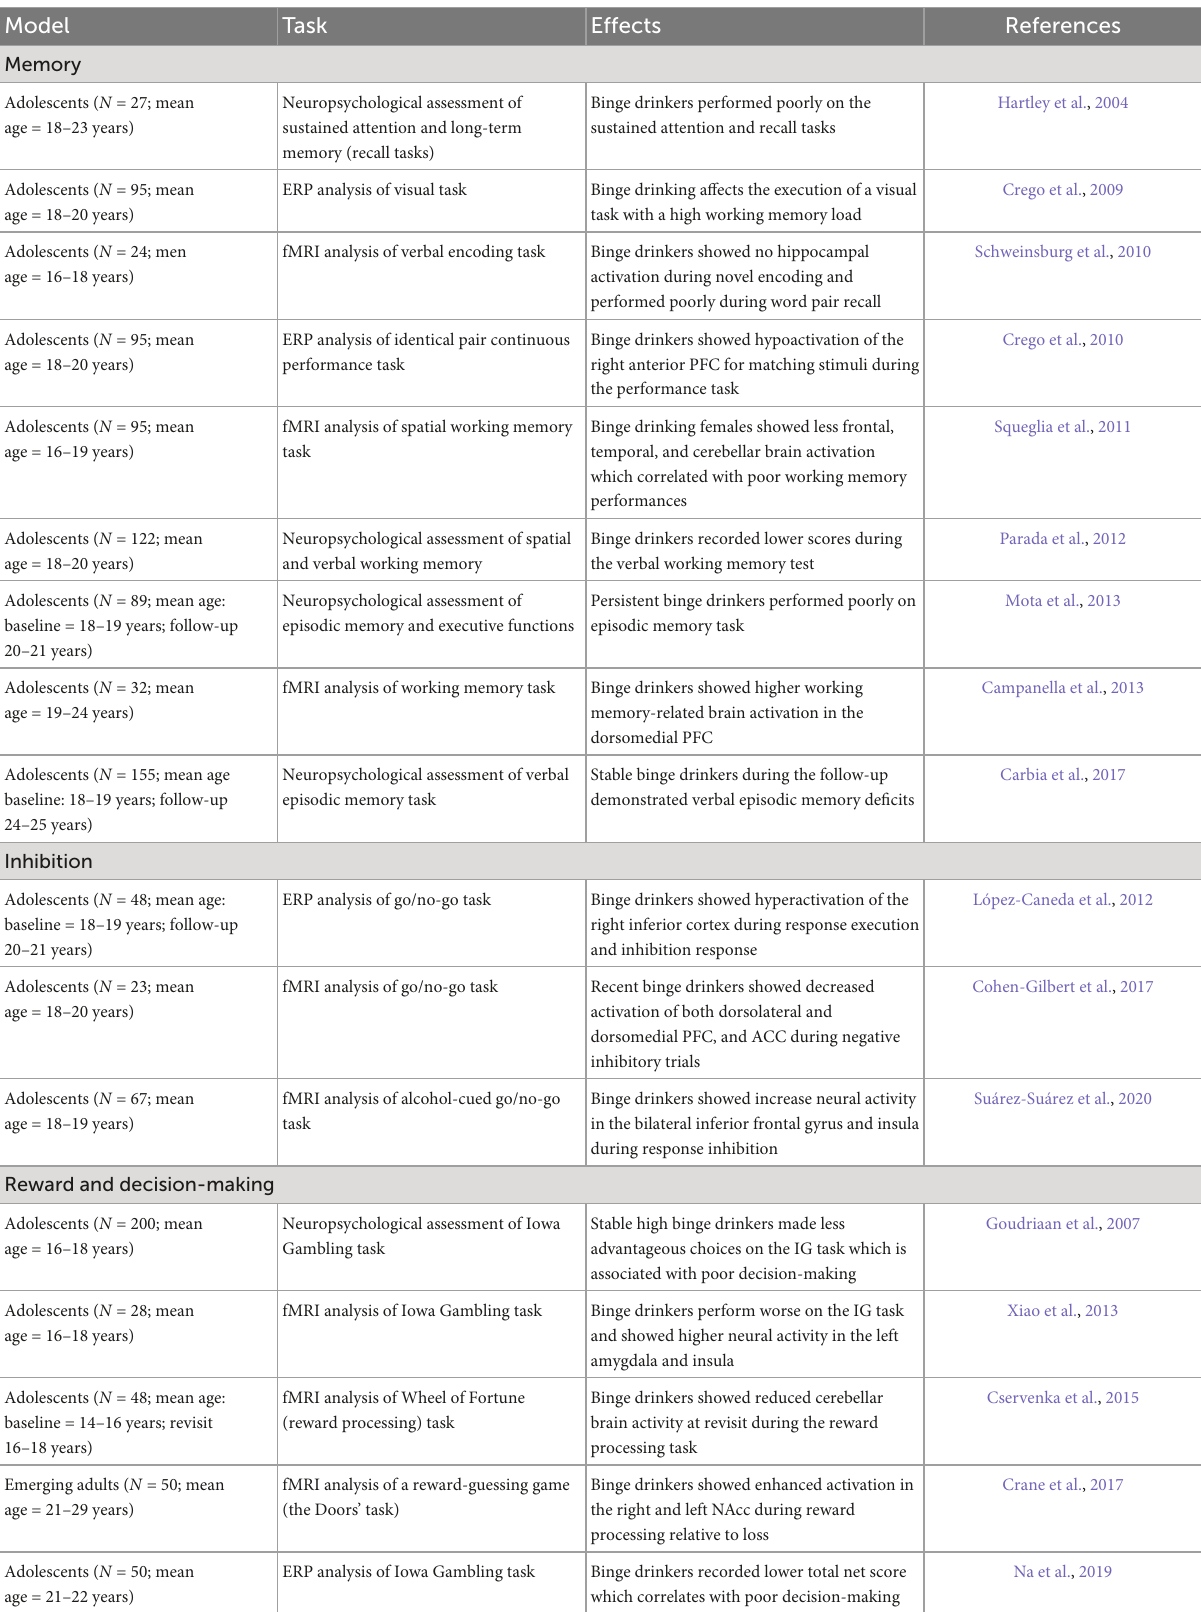
TABLE 3 Summary of behavioral studies exploring the effect of binge drinking in adolescents during cognitive tasks.